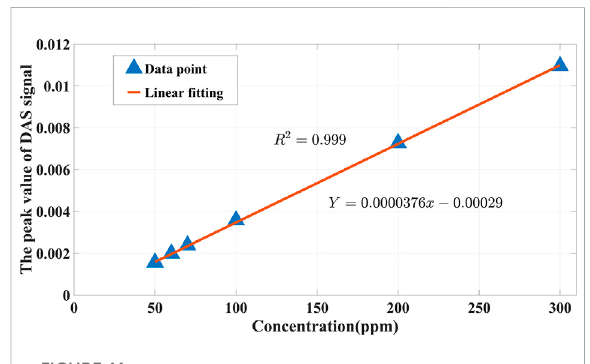
FIGURE 11 The fi tting result in the calibration experiment.